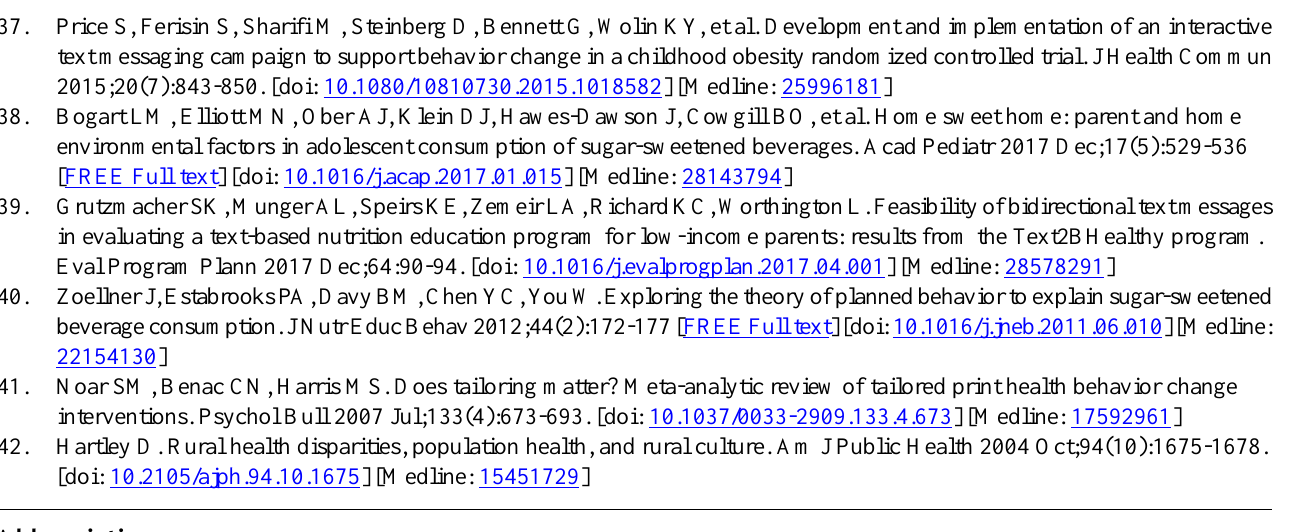
Abbreviations BEVQ-15: 15-item beverage intake questionnaire NIH: National Institutes of